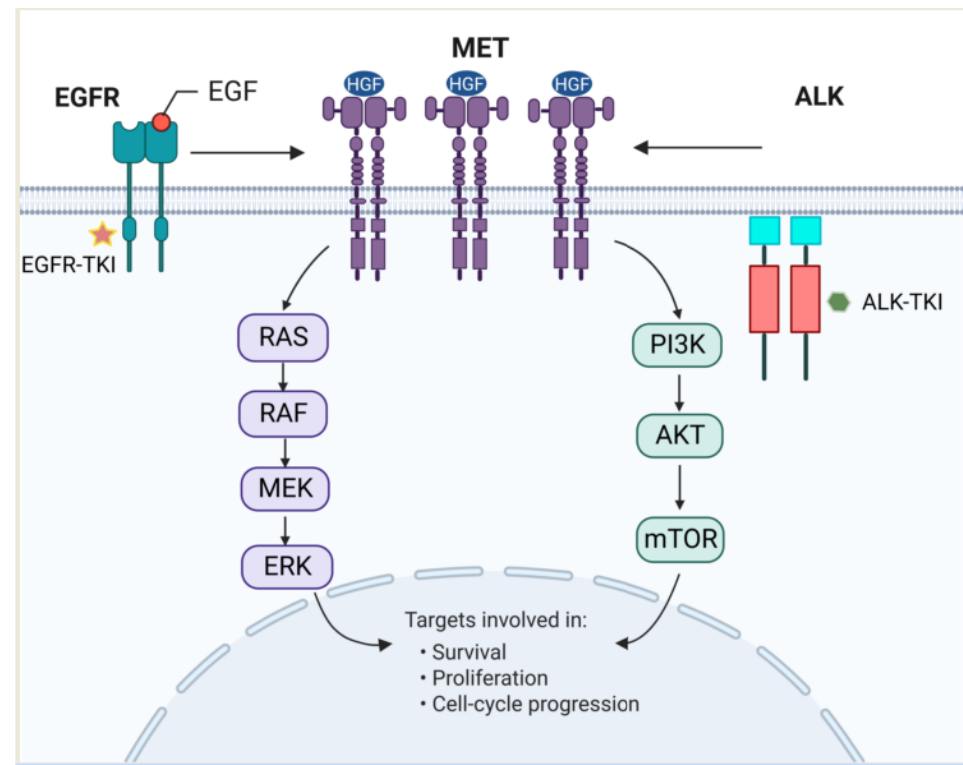
Figure 1. Mechanisms of MET amplification-mediated resistance to molecularly targeted therapies in non-small cell lung cancer (NSCLC). EGFR mutation or ALK -rearrangement as the primary driver oncogene shown. MET, EGFR, and ALK are all members of the RTK family, which regulates cellular proliferation and survival through common downstream pathways such as the PI3K-AKT-mTOR and RAS-RAF-MEK-ERK pathways.